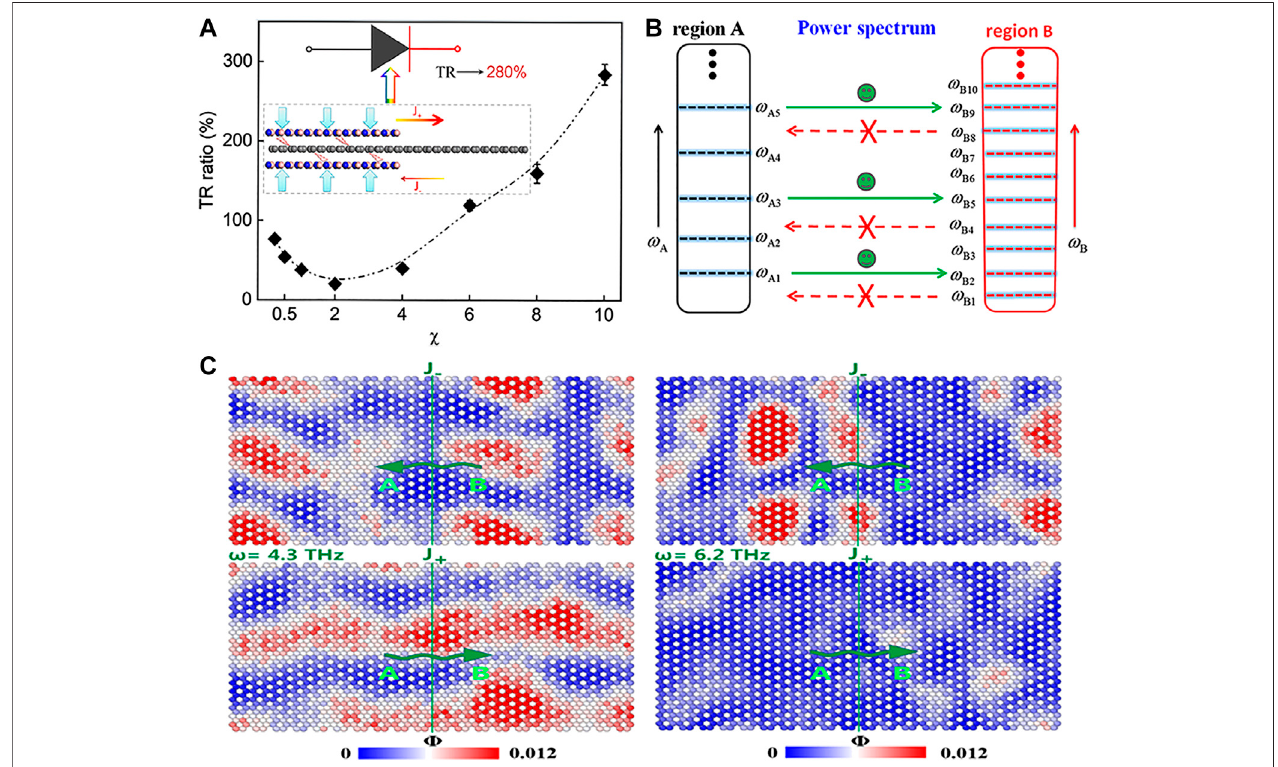
FIGURE 8 | (A) The dependence of the TR ratio on the coupling strength χ , the inset indicates a thermal recti fi er model based on graphene/h-BN vdW heterostructures. (B) The schematic diagram illustrates the mode-matching between region A and B. Clearly, the mode with frequency ω A in left side is basically able to match a speci fi c mode with ω B in right side, but the reverse is not true. (C) The spatial distribution of a low-frequency vibrational modes at 4.3 THz and 6.8 THz. Reproduced from (Chen et al., 2020b) with permission from American Chemical